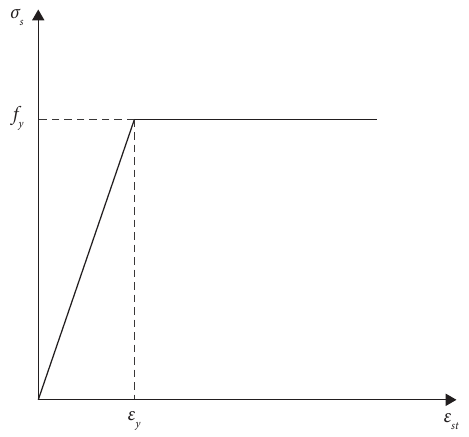
Figure 5: Te behavior of steel reinforcing bar in